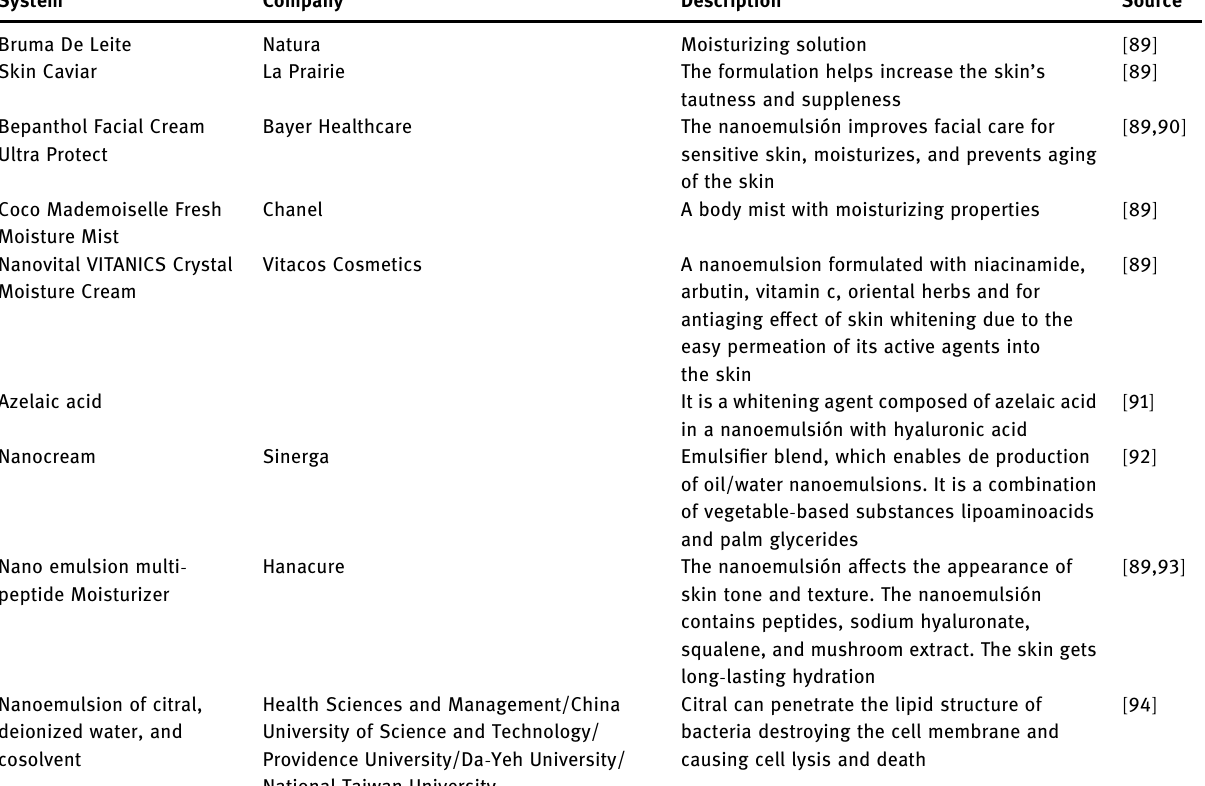
Table 3: Applications of nanoemulsions